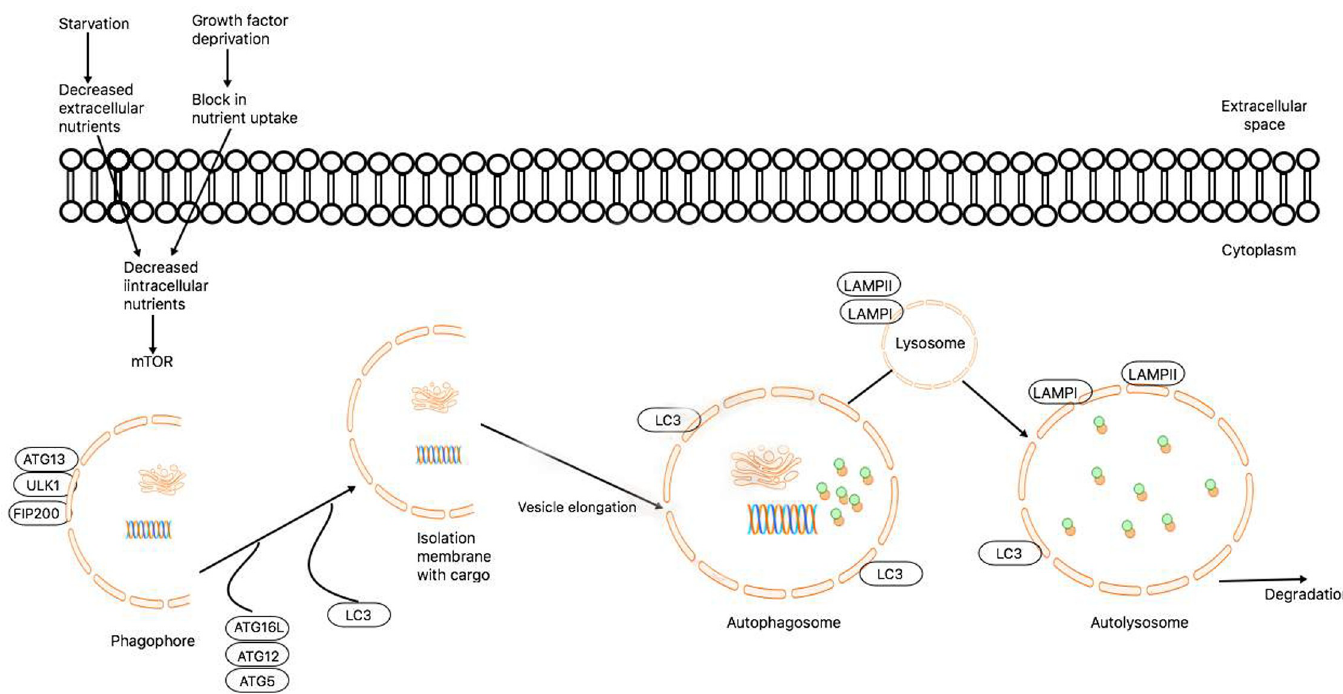
Fig 1. Molecular pathway of autophagy. Autophagy activation is controlled by several factors, including amino acid and nutrient deprivation, which stimulates mTOR- related pathways. Upon mTOR inhibition by starvation or rapamycin, ATG13 /ULK1/FIP200 form a stable complex, essential for autophagy activity. Highly coordinated autophagy-related proteins are recruited to the phagosphore to participate in the autophagosome formation. ATG7 is one of the crucial regulators of this process. Lipidation of LC3-I known as LC3-II is attached to the autophagosome membrane and is widely used to monitor autophagy induction. When autophagosome formation is completed, the fusion between autophagosome and lysosome is mediated by lysosomal membrane protein LAMP-2. ATG12 conjugation to ATG5 is a crucial step in autophagosome formation. ATG7 regulates ubiquitin-like reaction that mediates this mechanism and subsequent processes in the autophagy machinery.